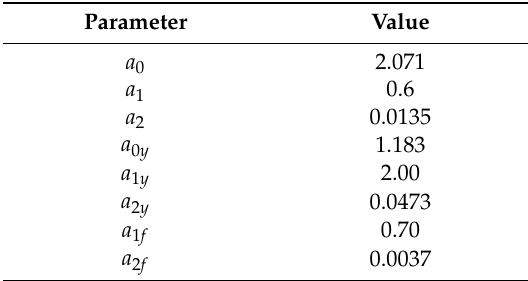
Table 1. Parameters for asphalt concrete (AC) material with f c = 4.6 MPa.